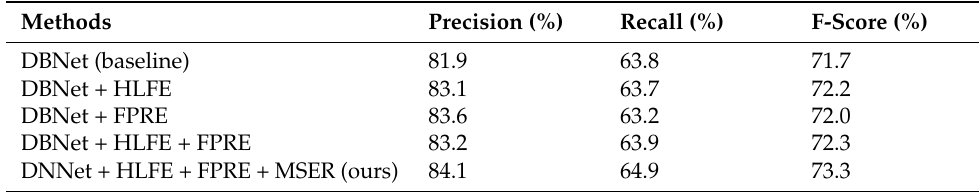
Figure 9. Comparison of visualization results of the method proposed in this paper and original DBNet model on natural scene street sign (NSSS) dataset: ( a ) is the result of the proposed method in this paper, and ( b ) is the result of the original DBNet model.